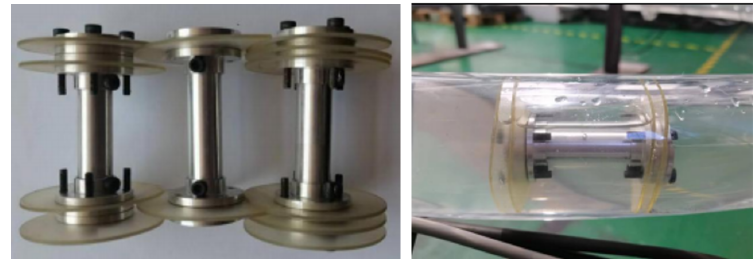
Figure 27 . Robot models with di ff erent numbers of cups.